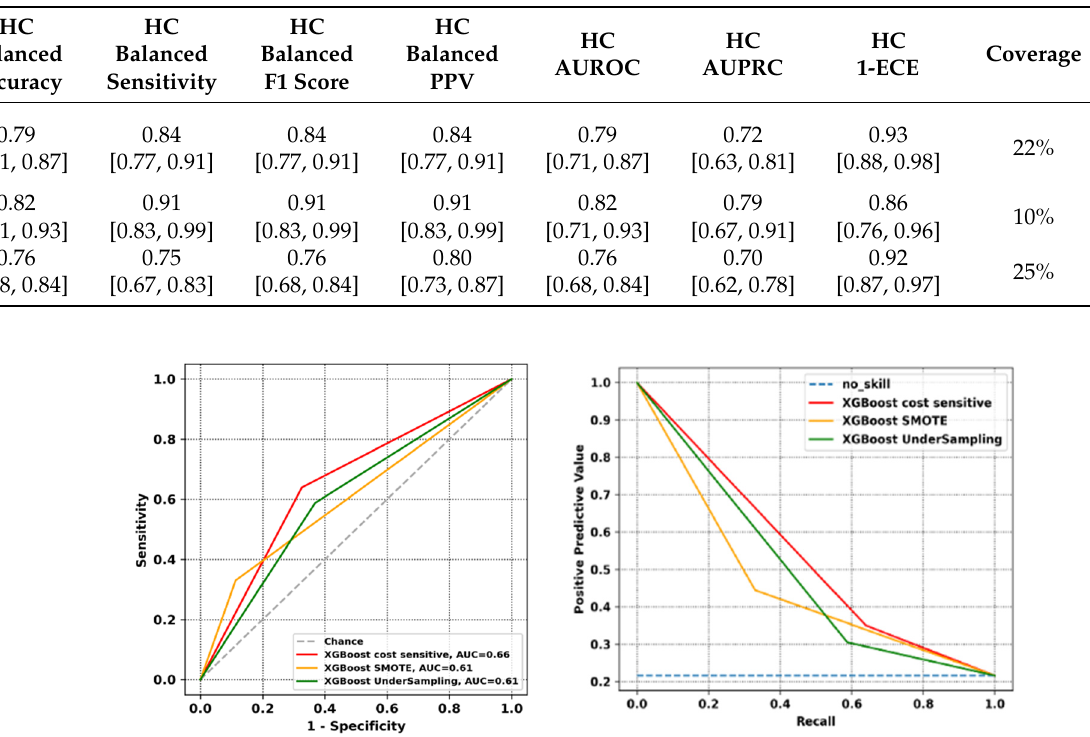
Table 6. The models’ high confidence performance on test set. Binomial confidence intervals are shown at 95% confidence level.